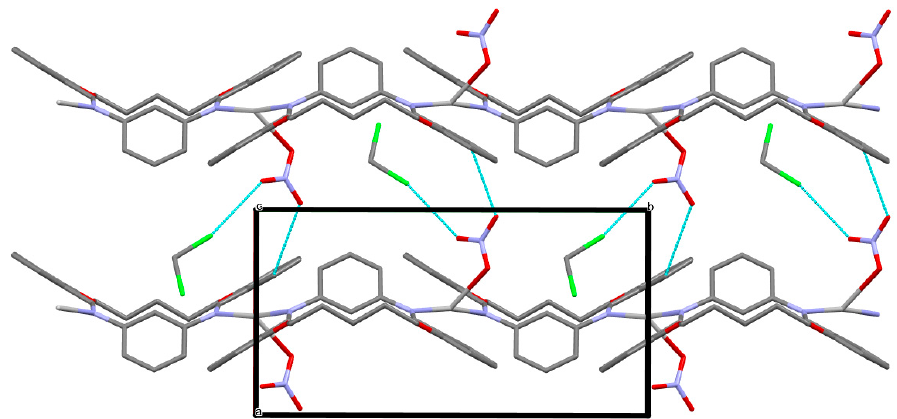
Figure 7. Representation of crystal packing in BUPREL. C–H ··· O and Cl ··· O interactions between anions, solvent and ligand molecules are represented by blue dashed lines. Hydrogen atoms are omitted for clarity. The view is down the c axis. Table 3. Thermochemical radii and volume of anions used for the preparation of CPs.